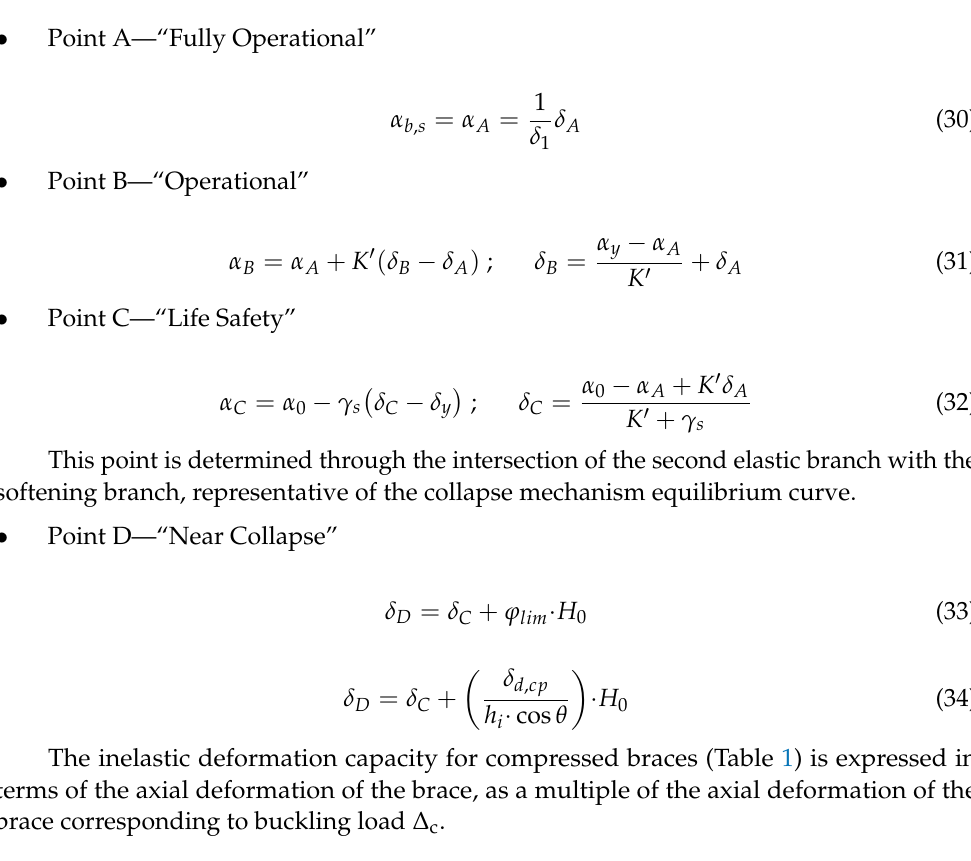
Table 1. Capacity in terms of axial deformation for braces in